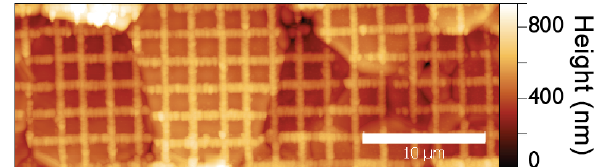
Figure 14. Atomic force micrograph of a deformed grid in synthetic forsterite deformed at T = 1110 ◦ C and P c = 1 atm to 5% shorten- ing. The chromium lines are about 110nm thick and are clearly vis- ible in the height map. The grain structure is also clearly visible and both the height difference and the offset of the lines show evidence of grain displacement. Amanda Dillman performed the deformation experiment and the AFM observations for this sample.